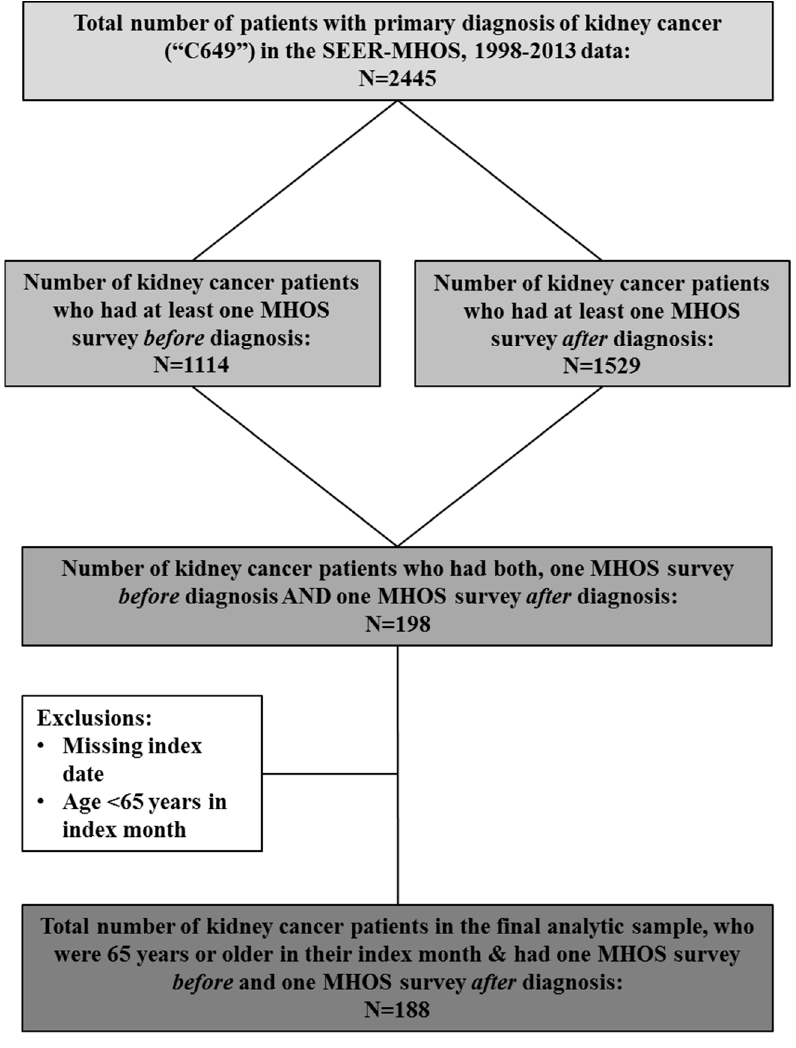
Figure 1. Study sample selection.